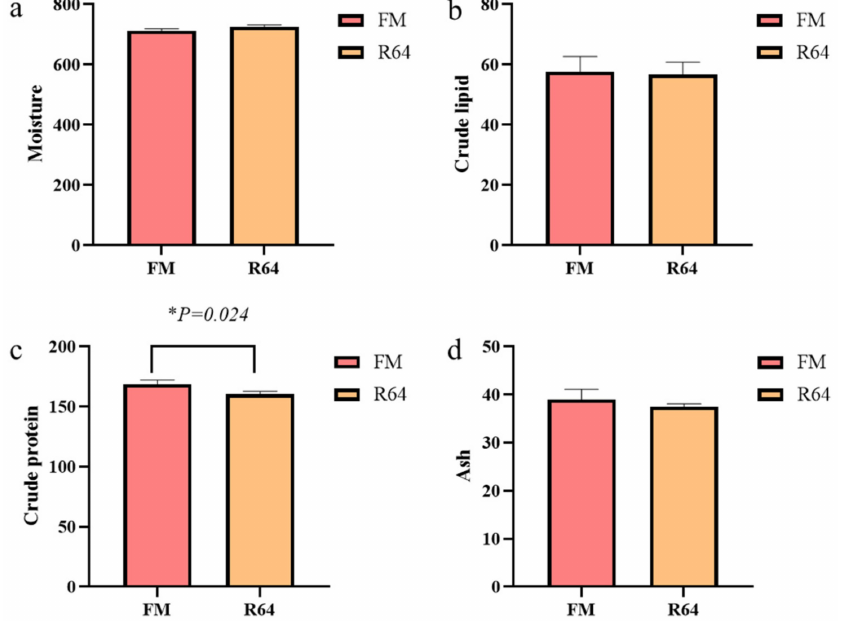
Figure 3. Effects of fishmeal replacement by low-gossypol cottonseed meal on whole-body proximate composition of juvenile S. sihama (g/kg wet matter). ( a ): Moisture, ( b ): Crude lipid, ( c ): Crude protein, ( d ):